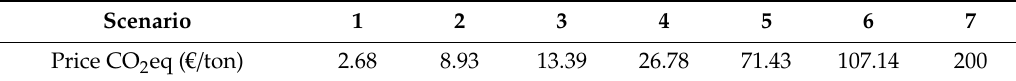
Table 2. Price per ton of CO 2 eq in carbon emission trading (Case